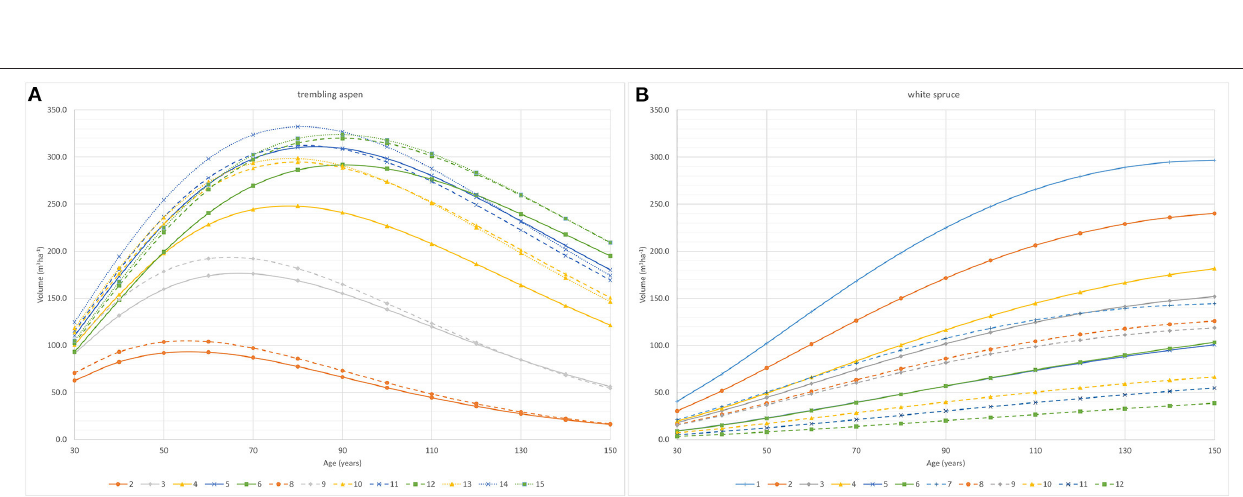
2020). In this study, conducted in young mixtures of